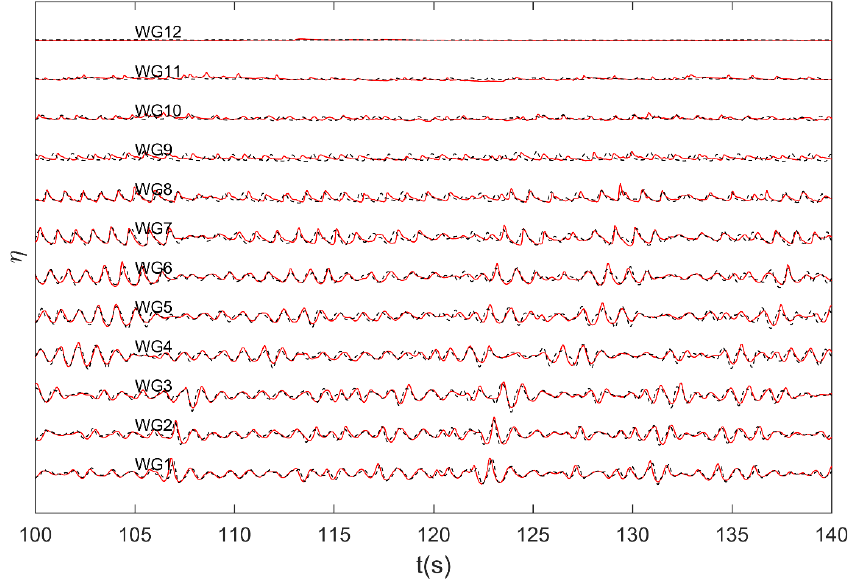
Figure 9. Comparison of the time series of wave surfaces for case 278. Red lines in the figure are measured data and black dashed lines are simulated results.